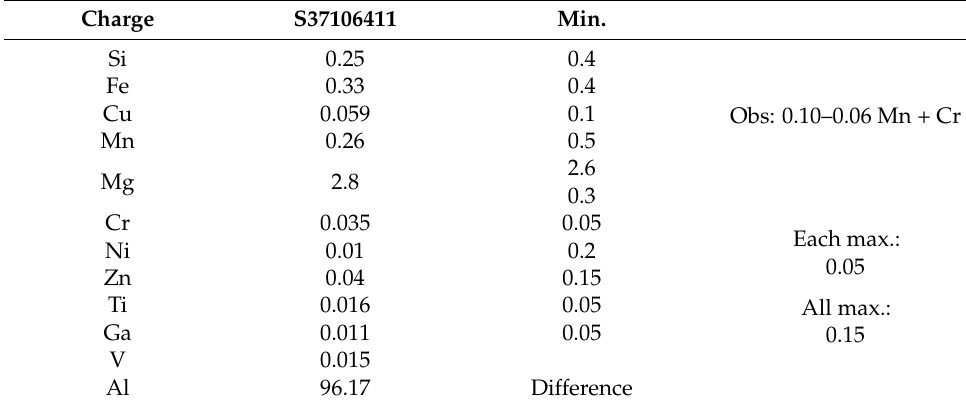
Table 1. Chemical composition of AlMg3